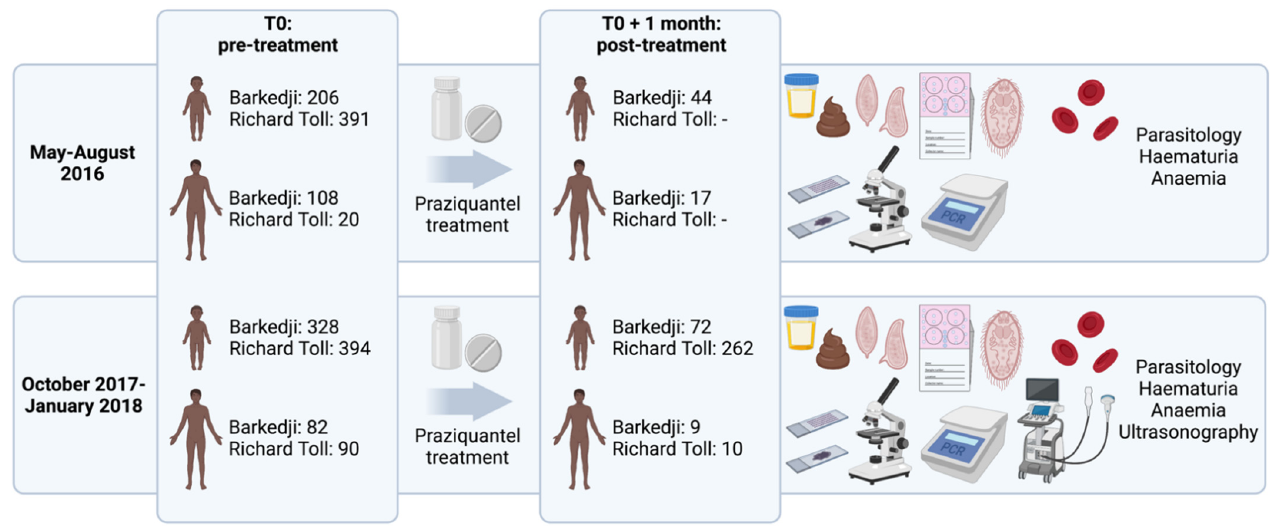
Figure 1. Sampling design of the study conducted in two areas of northern Senegal: Barkedji and Richard Toll. Only parasitological (urine filtration, Kato–Katz, miracidial hatching) and clinical examinations (hematuria and anemia) were performed during the May–August 2016 survey, whereas parasitological, clinical and ultrasonographical examinations were performed during the October 2017–January 2018 survey. School-aged children ( n = 1319) were randomly selected, while adults ( n = 300) were self-selecting volunteers. All individuals diagnosed with schistosomiasis were treated with 40 mg/kg of praziquantel. For both surveys, a follow-up was conducted approximately one month after treatment, with the same examinations as pre-treatment (i.e., parasitological and clinical examinations in 2016, n = 61; parasitological, clinical and ultrasonographical examinations in 2017, n = 353). Numbers indicate individuals that received at least one of the parasitological or clinical examinations. Created with BioRender.com (3 August 2021).